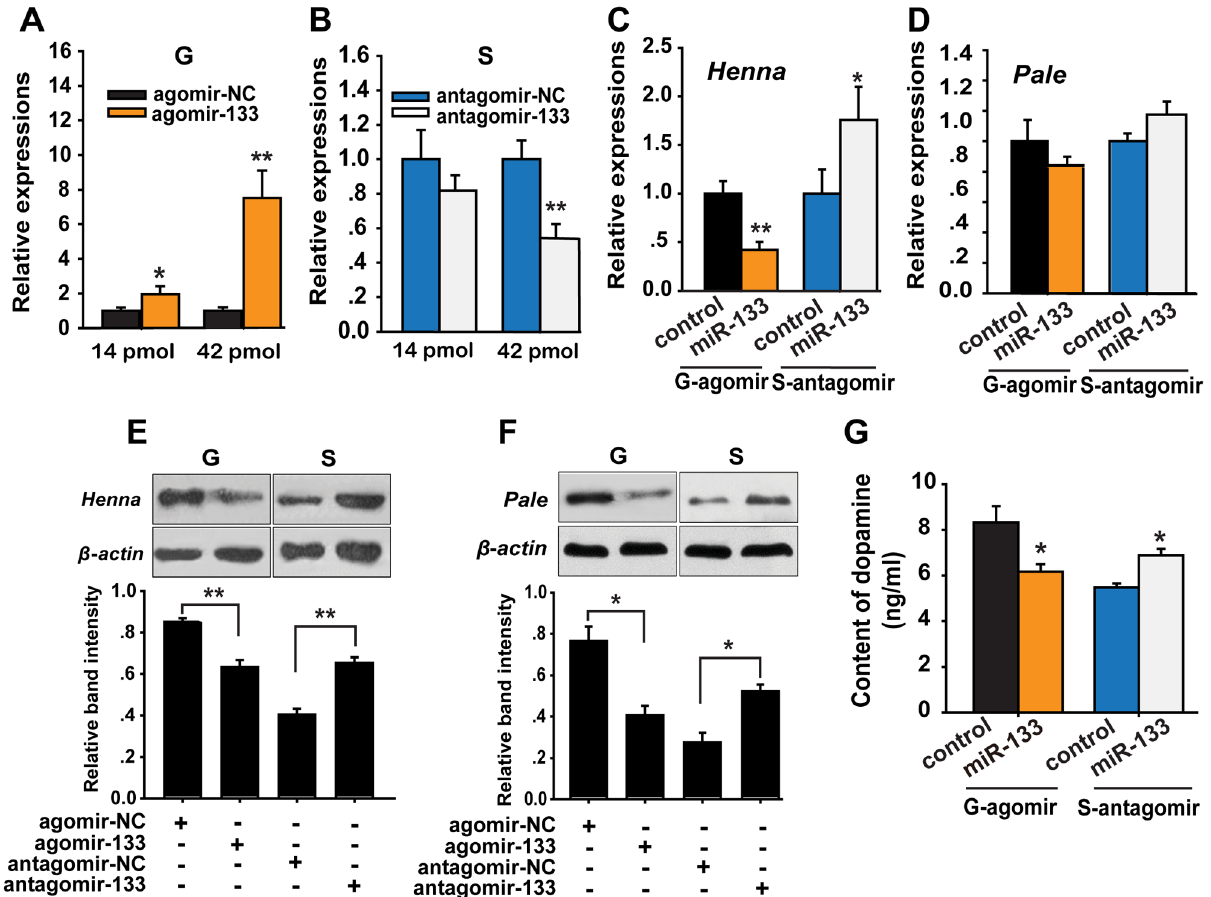
Figure 4. miR-133 controls dopamine production by regulating henna and pale expression in the locust brain. (A, B) The expression levels of miR-133 were determined 48 h after injection in gregarious locusts (G) and in solitary locusts (S) after treatment with agomir or antagomir, respectively (14 or 42 pmol) using qPCR. (C, D) The effects of 42 pmol of agomir- and antagomir-133 treatment 48 h after injection on the mRNA expression levels of henna and pale in gregarious and solitary locust brains were studied using qPCR. (E, F) The effects of 42 pmol of agomir- and antagomir-133 48 h after injection on the protein expression levels of henna and pale in gregarious and solitary locust brains were studied using western blot analysis. (G) Dopamine production after treatment with 42 pmol agomir or antagomir-133 treatment in gregarious and solitary locusts brains was evaluated using HPLC-MS. The qPCR and HPLC-MS data are shown as the mean 6 SEM ( n =6). The western blot bands were quantified using densitometry and are expressed as the mean 6 SEM ( n =4). * p , 0.05; ** p ,